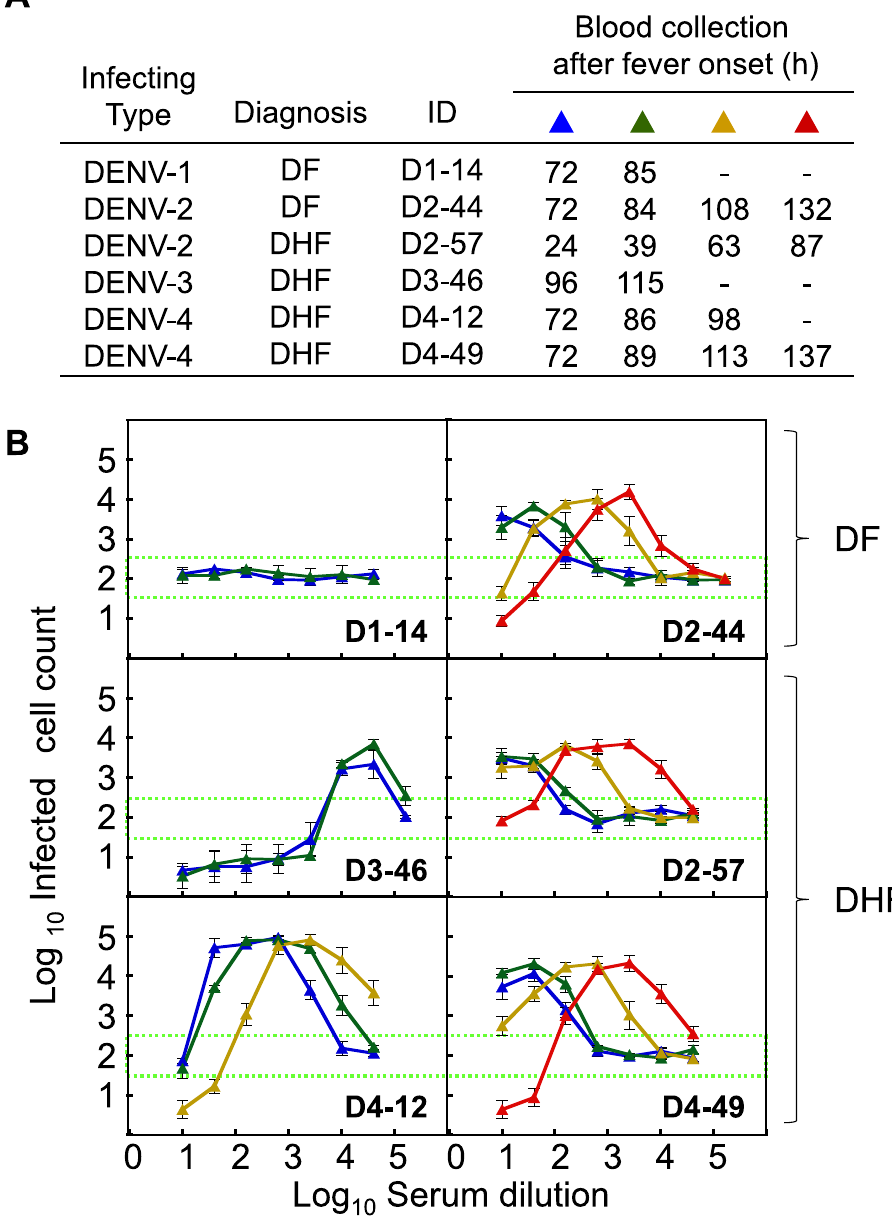
Figure 1. Balance between neutralizing and enhancing activities against autologous virus. ( A ) Demographic data for the six dengue patients enrolled in this study. Blood samples were collected on the day of hospitalization and the following time points at 12–24 h intervals until a maximum 137 h after fever onset. ( B ) NAb/EAb balance activity against the autologous virus. The NAb/EAb-balance assay was performed with a combination of autologous virus and serum. The blue , green , yellow and red triangles, corresponding to ( A ), indicate the hours after fever onset. The abscissa indicates the serum dilutions and the ordinate shows the numbers of infected cells (both expressed as log10). Each data point represents the average of two separate assays; error bars indicate the SDs. Dotted lines indicate the mean numbers of infected cells plus or minus three times the SD (mean ± 3SD), to define neutralizing or enhancing activity,